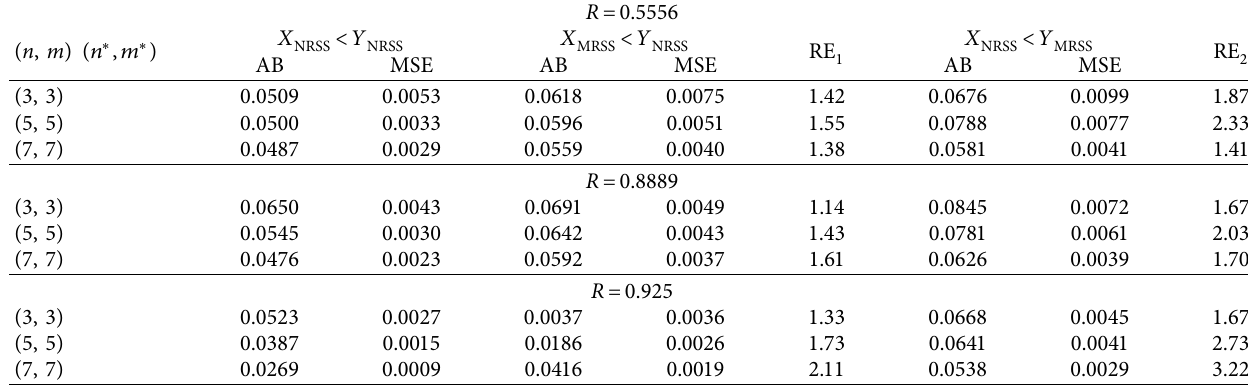
Table 4: Some measures of SSR estimates based on MRSSO and NRSS.